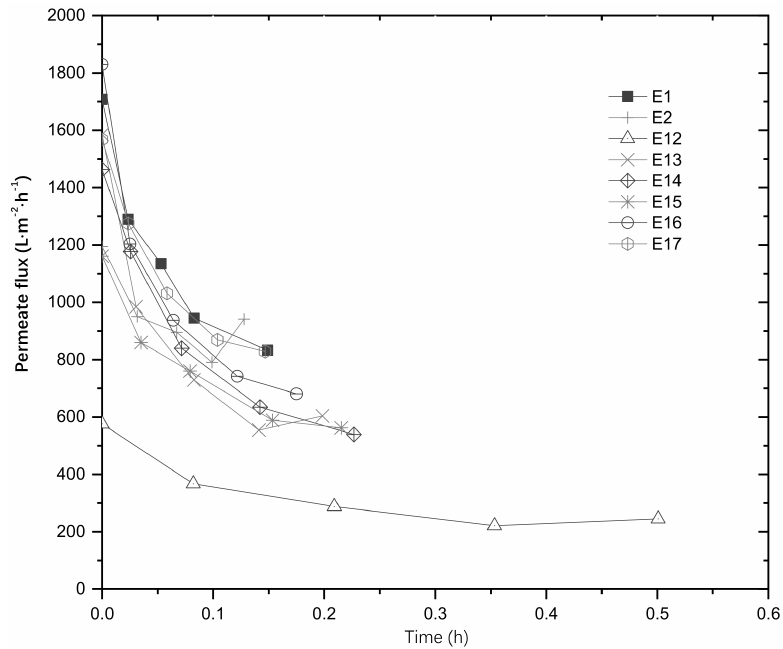
Figure 3. Permeate flux comparison between membranes modified with 125 mg of ZnO and treated at different temperatures.